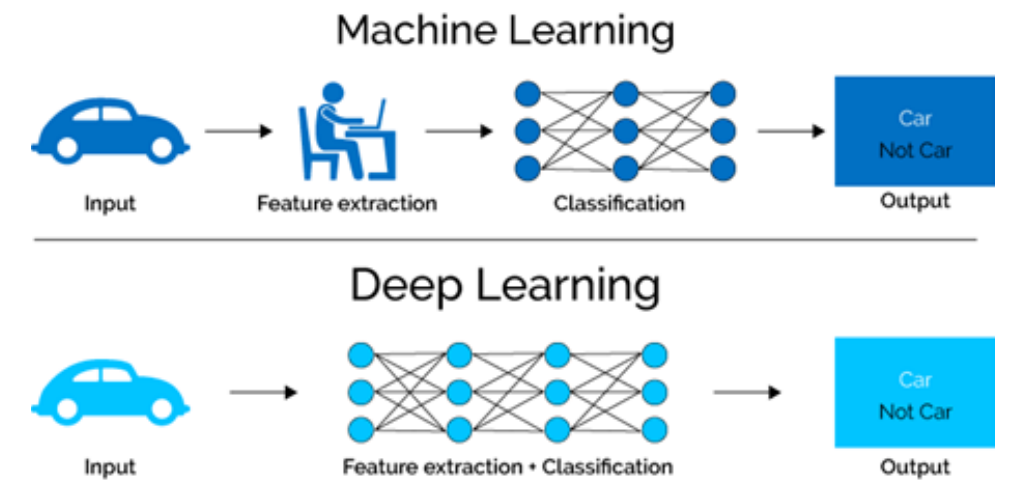
Figure 7. Working on deep-learning